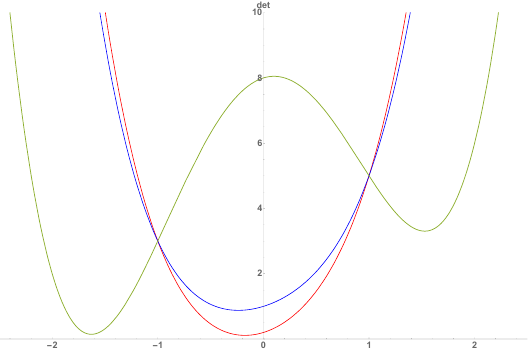
Figure 1 . Here we plot the dimensionless determinant of the spatial sections with constant, ( t; r ) det = f ( r ) g ( r ) (cid:27) 3 ‘ (cid:0) 4 = 4 versus the r coordinate. All the plots have m‘ = 1. The plots are for (cid:27) = 3 : 2 and (cid:27) = 4 that have a single throat (from down up) and (cid:27) = 11 with two throats and an anti-throat. As expected, det is asymmetric unless m = 0. For a given m all curves intersect at r = (cid:6) 1 as f is independent of (cid:27)